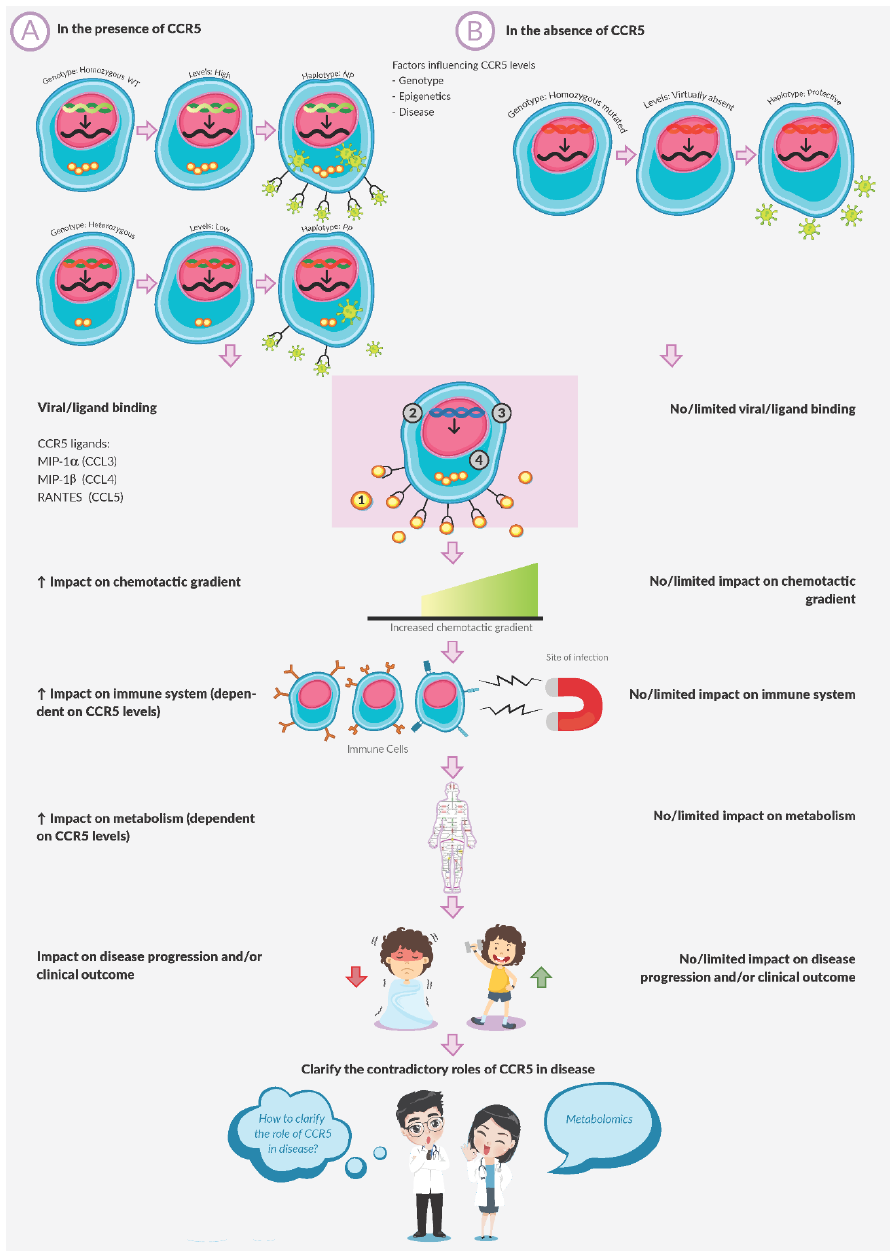
Figure 1. Graphical display of the cascading effect of CCR5 on signal transduction, chemotaxis, immune function and metabolism, all of which ultimately impact disease progression and/or clinical outcome. The cascading effect presents an opportunity to specifically measure the immuno-metabolic changes through metabolomics. Several factors influence CCR5 status. We depict scenarios for when ( A ) CCR5 is present (high and low levels) and ( B ) absent. In the presence of CCR5, (1) viral / ligand binding occurs and (2) induces a cell signaling cascade that causes (3) gene activation leading to (4) a protein product and / or cellular response. ( B ) Lack of viral / ligand binding due to the absence of CCR5 limits the signaling cascade and its subsequent processes. Abbreviations: CCR5—C-C chemokine receptor 5; CCL3—C-C chemokine ligand 3; CCL4—C-C chemokine ligand 4; CCL5—C-C chemokine ligand 5; MIP1- α — macrophage inflammatory protein one alpha; MIP1- β —macrophage inflammatory protein one beta; NP—non-protective; PP—partially protective; RANTES—regulated upon activation, normal T-cell expressed and secreted; WT—wild